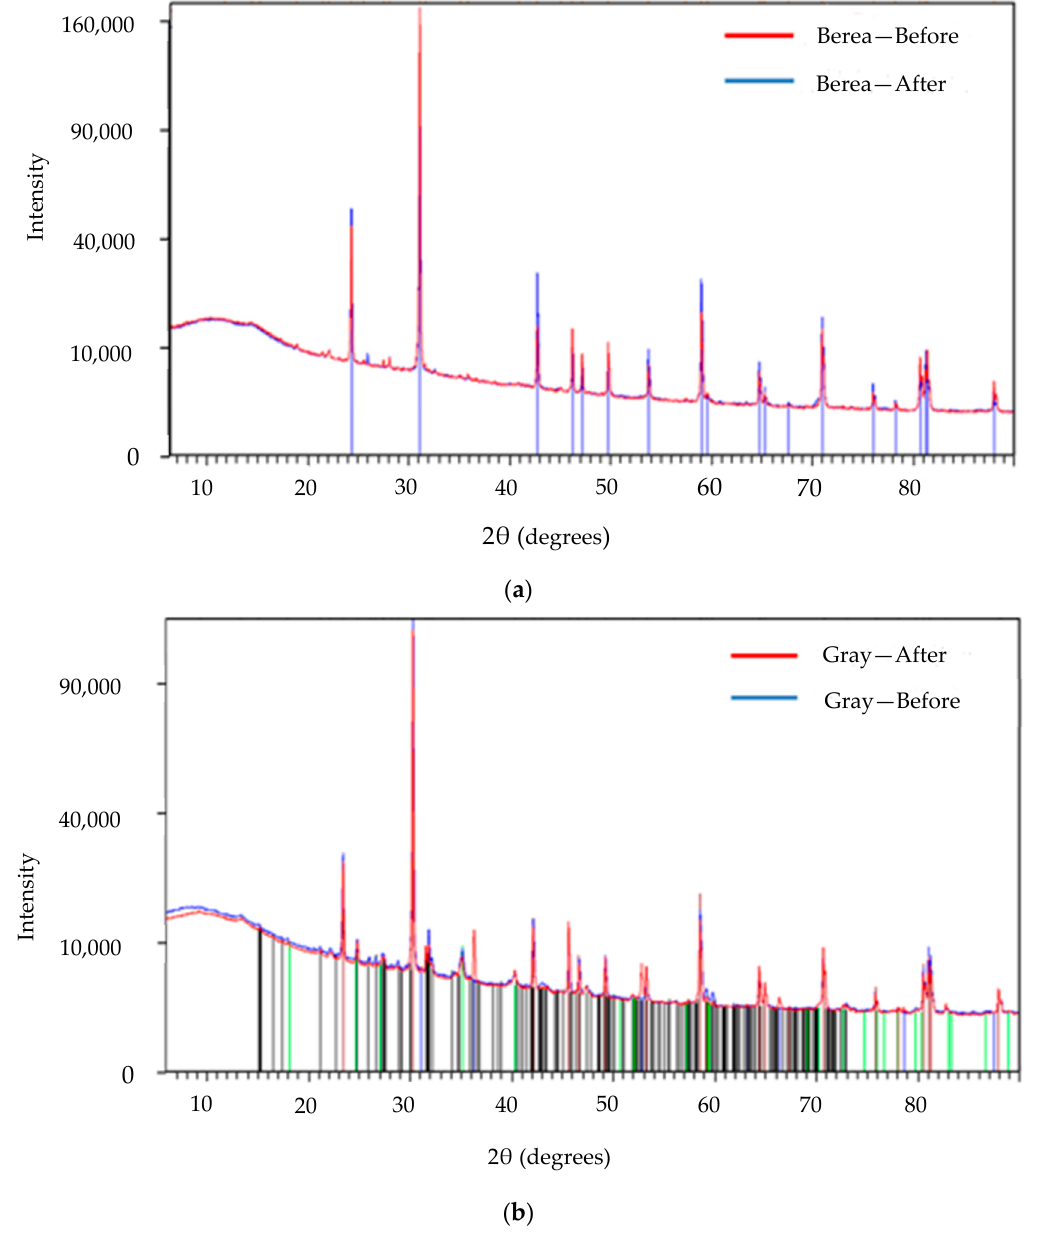
Figure 7. XRD Images for Berea’s mineralogical composition ( a ) and Bandera Gray ( b ) before and after flooding.